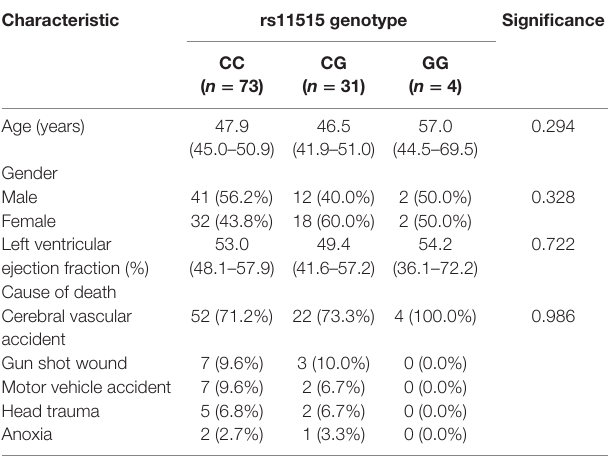
TaBle 2 | characteristics of the 108 heart donors relative to their rs11515 genotype.